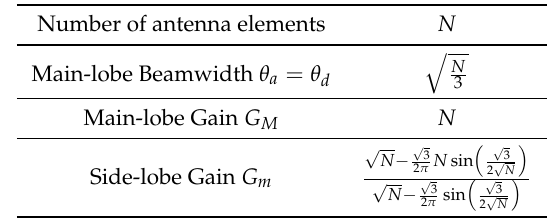
Table 1. 3D Antenna Pattern [29].